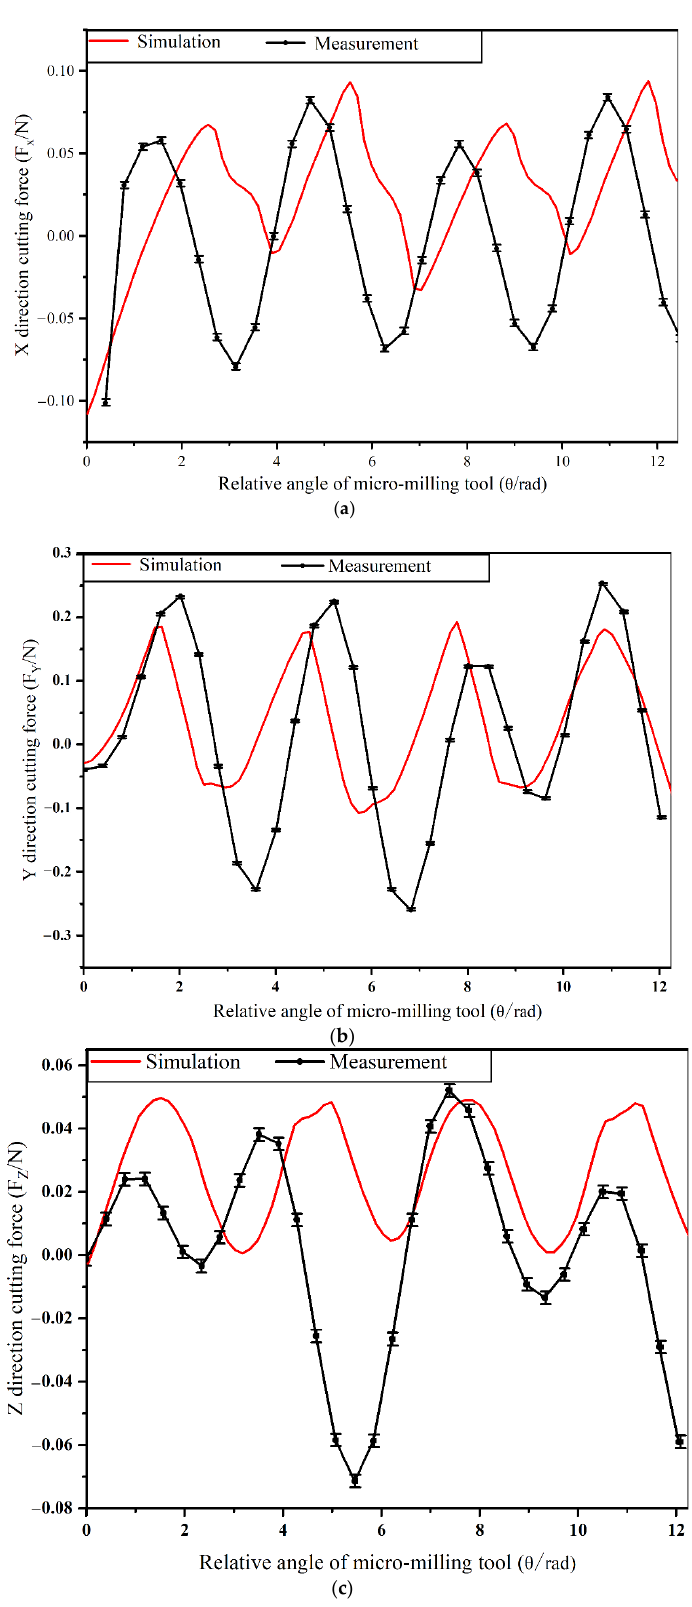
Figure 20. Experimental verification of three-dimensional dynamic force model: ( a ) Forces in X- direction; ( b ) Forces in Y-direction; ( c ) Forces in Z-direction.